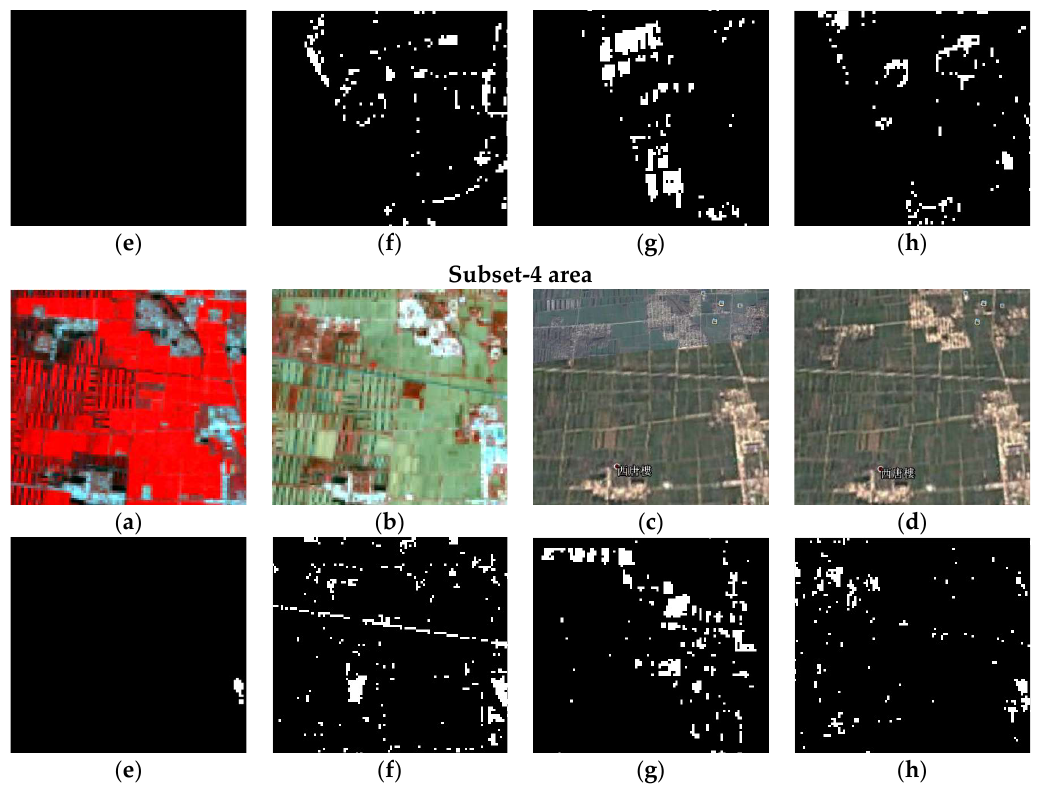
Figure 11. Change detection results for two subset areas: ( a ) Landsat images on 3 April 2010; ( b ) Landsat images on 2 October 2015; ( c ) Google earth image at 2010; ( d ) Google earth image at 2015; and change detection result of the proposed method ( e ), CCDC ( f ), CVA ( g ) and PCC ( h ).